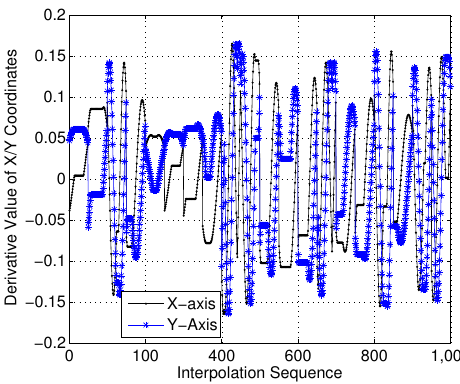
Figure 17. First-order derivatives of X / Y -axis coordinates (case 1).